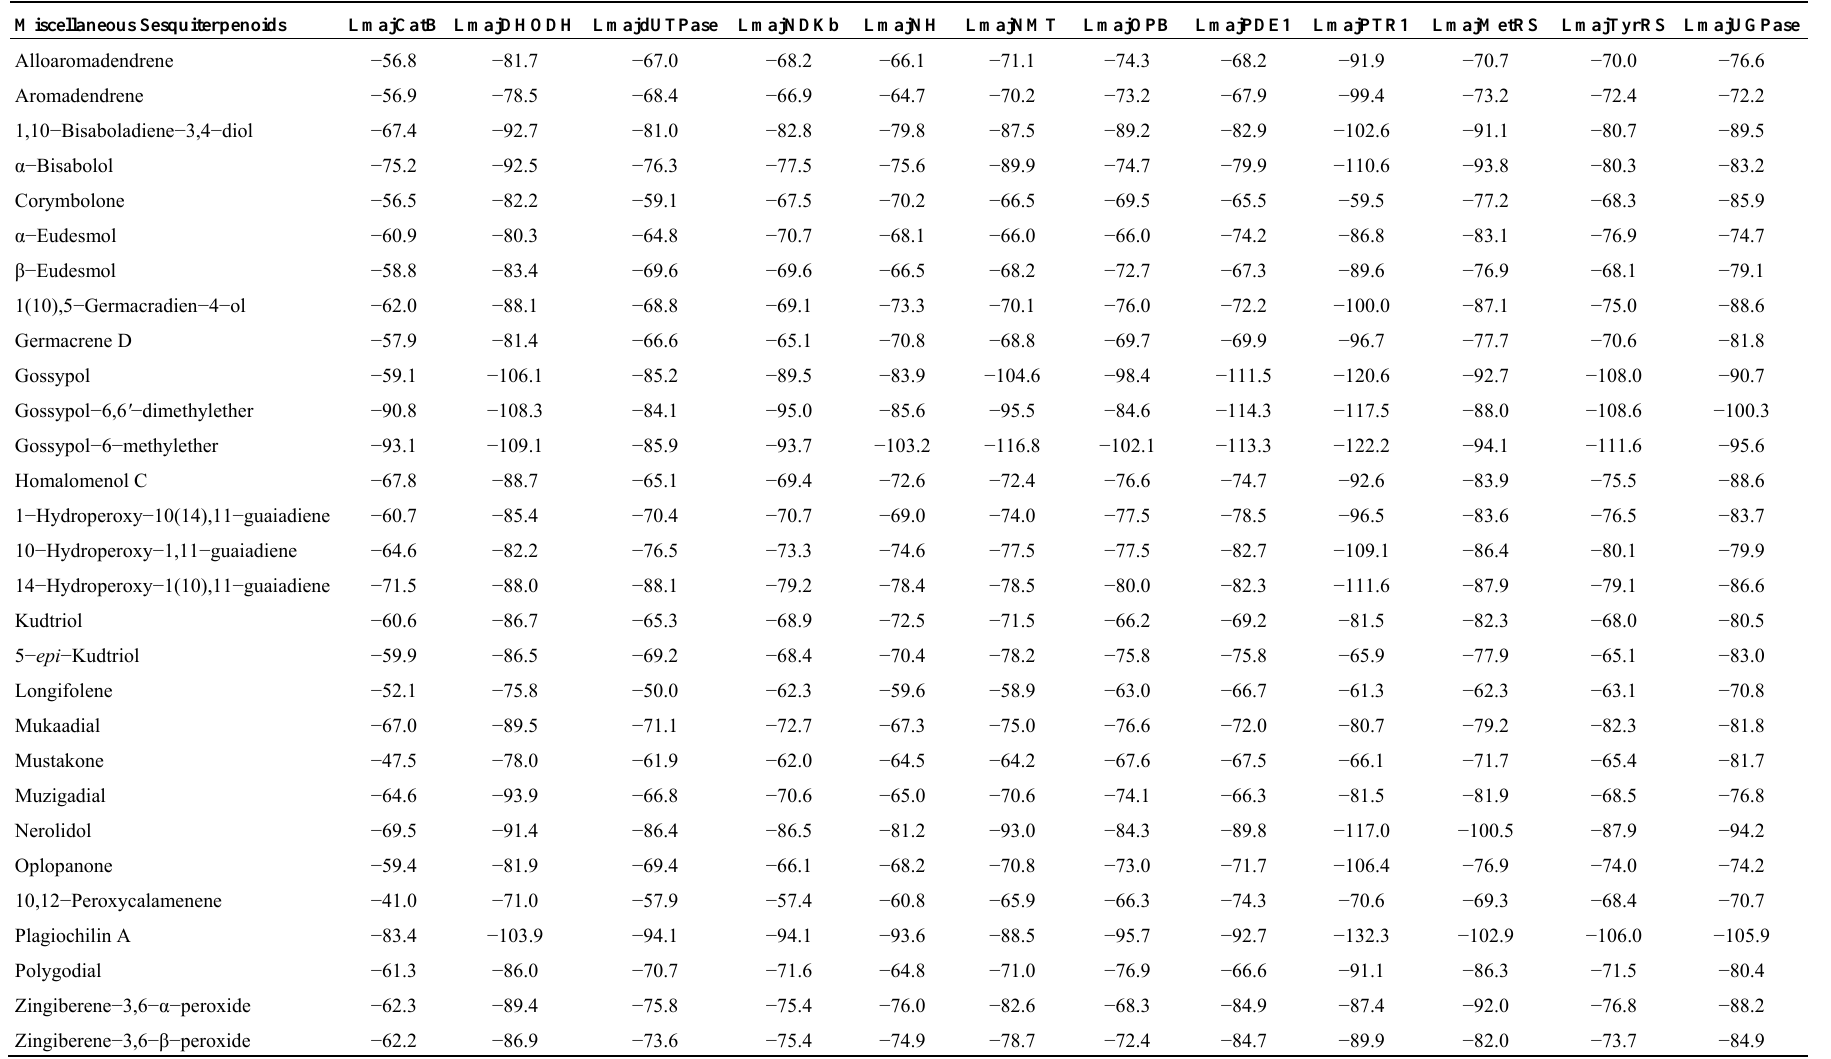
Table 13. MolDock docking energies (kJ/mol) of miscellaneous sesquiterpenoids with Leishmania major protein